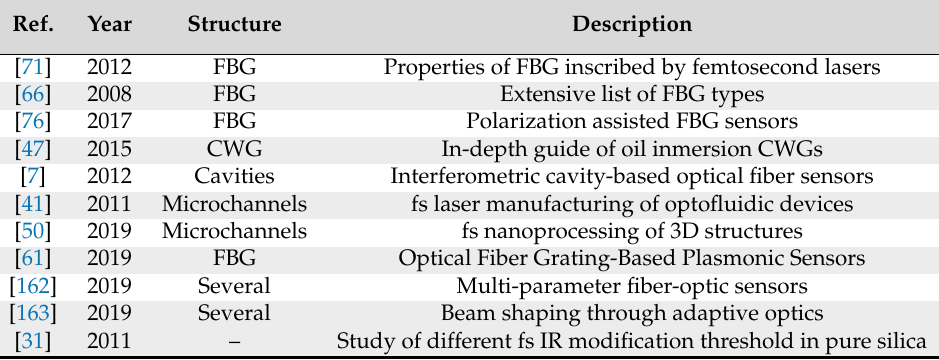
Table 8. List of selected further readings to delve into the topics discussed in this work.